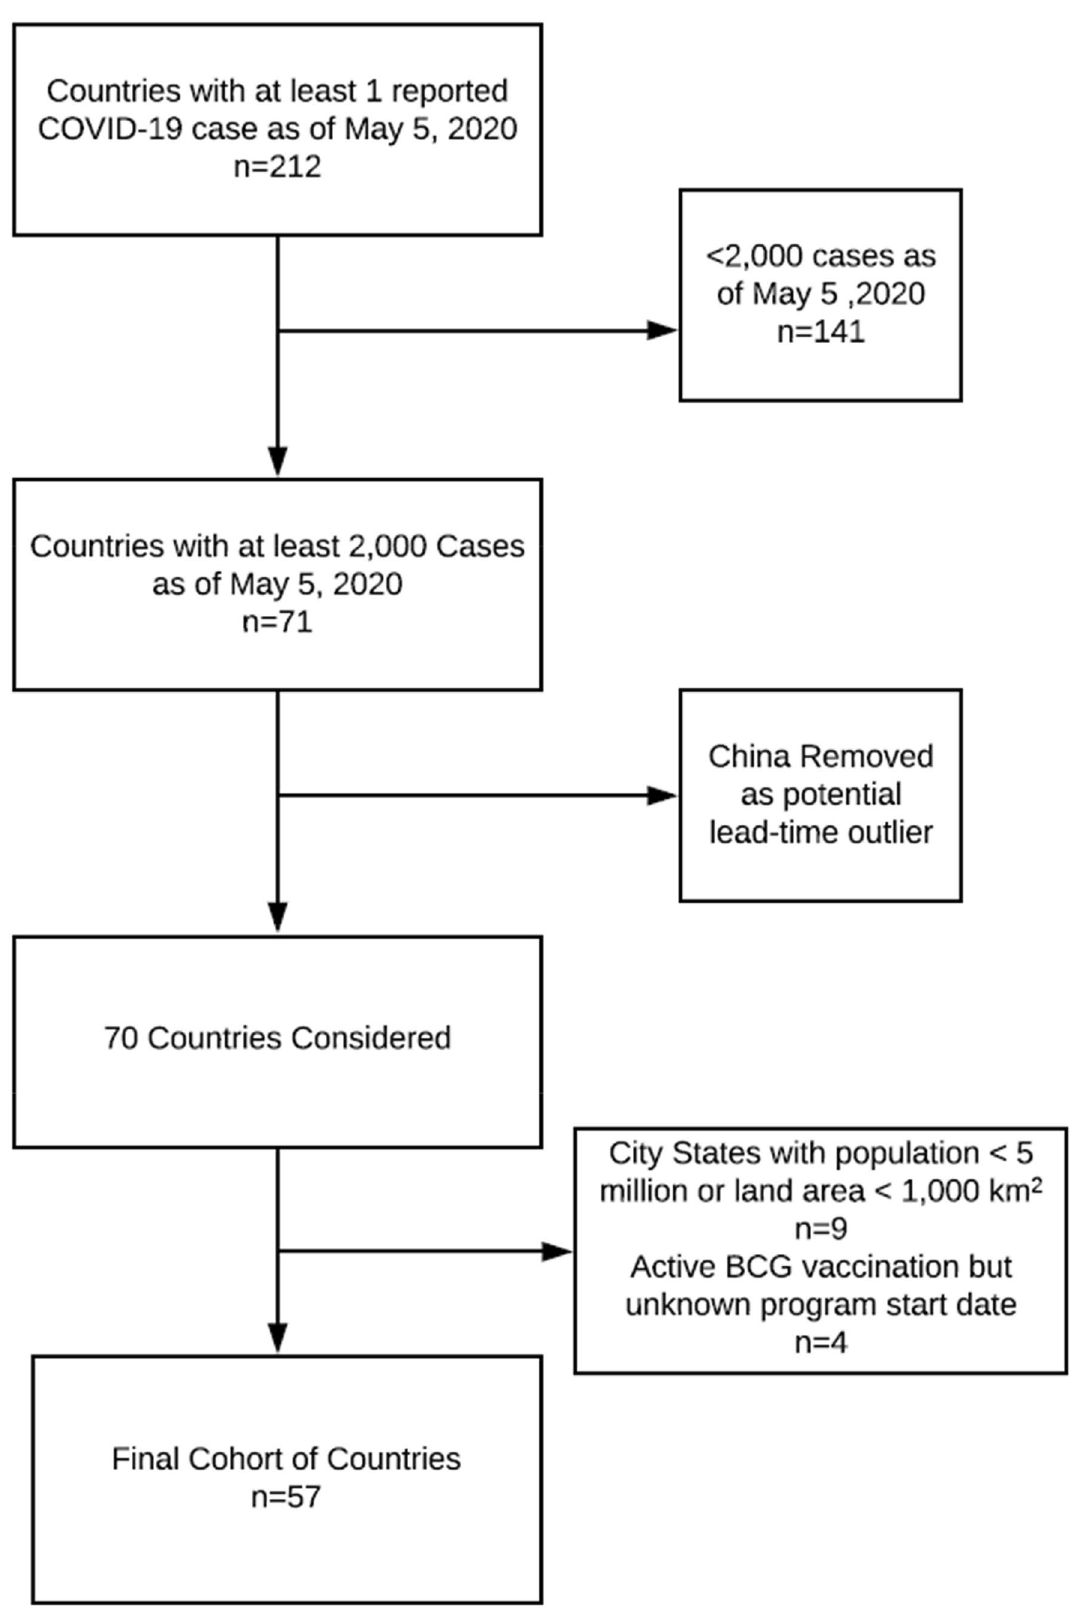
Figure 1. Consort diagram for the selection of countries included in evaluation. 212 countries and territories were initially screened with at least 1 case of COVID-19 as of May 5, 2020. Based on predetermined inclusion and exclusion criteria, 57 countries were included in the analysis. Figure was created using Lucidchart available at https ://www.lucid chart .com/pages